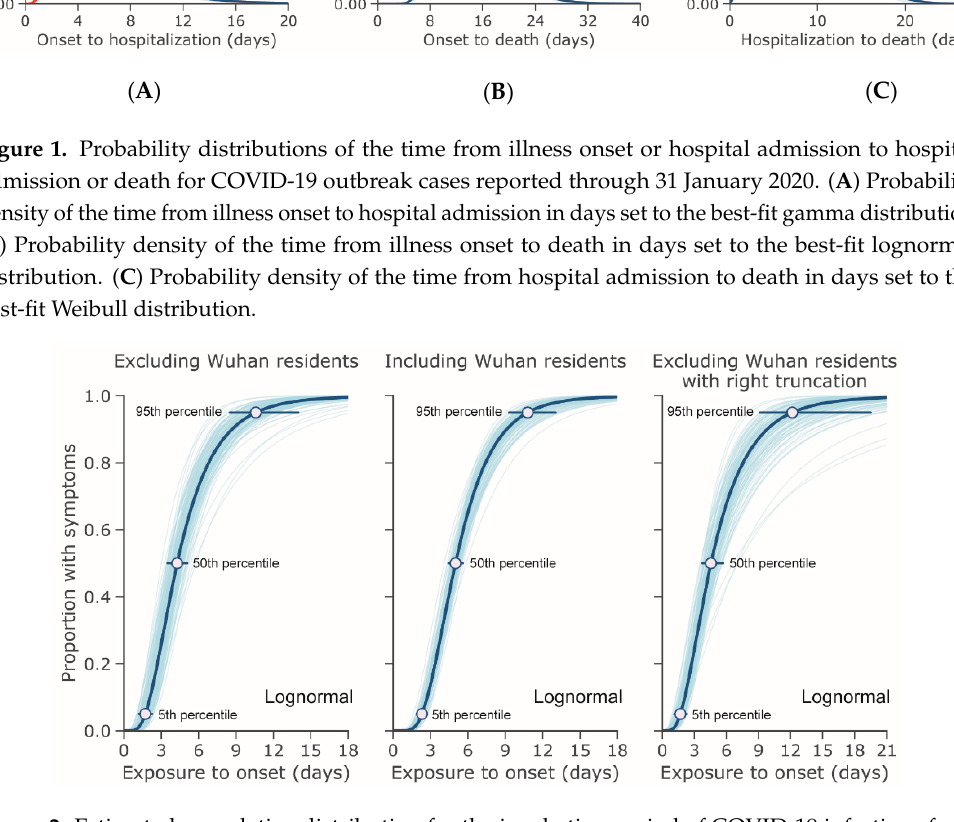
Figure 2. Estimated cumulative distribution for the incubation period of COVID-19 infections from outbreak cases reported through 31 January 2020. The data are from public case reports. Left and center: non-truncated estimates excluding ( n = 52) and including ( n = 158) Wuhan residents. Right: right-truncated estimates excluding Wuhan residents ( n = 52).